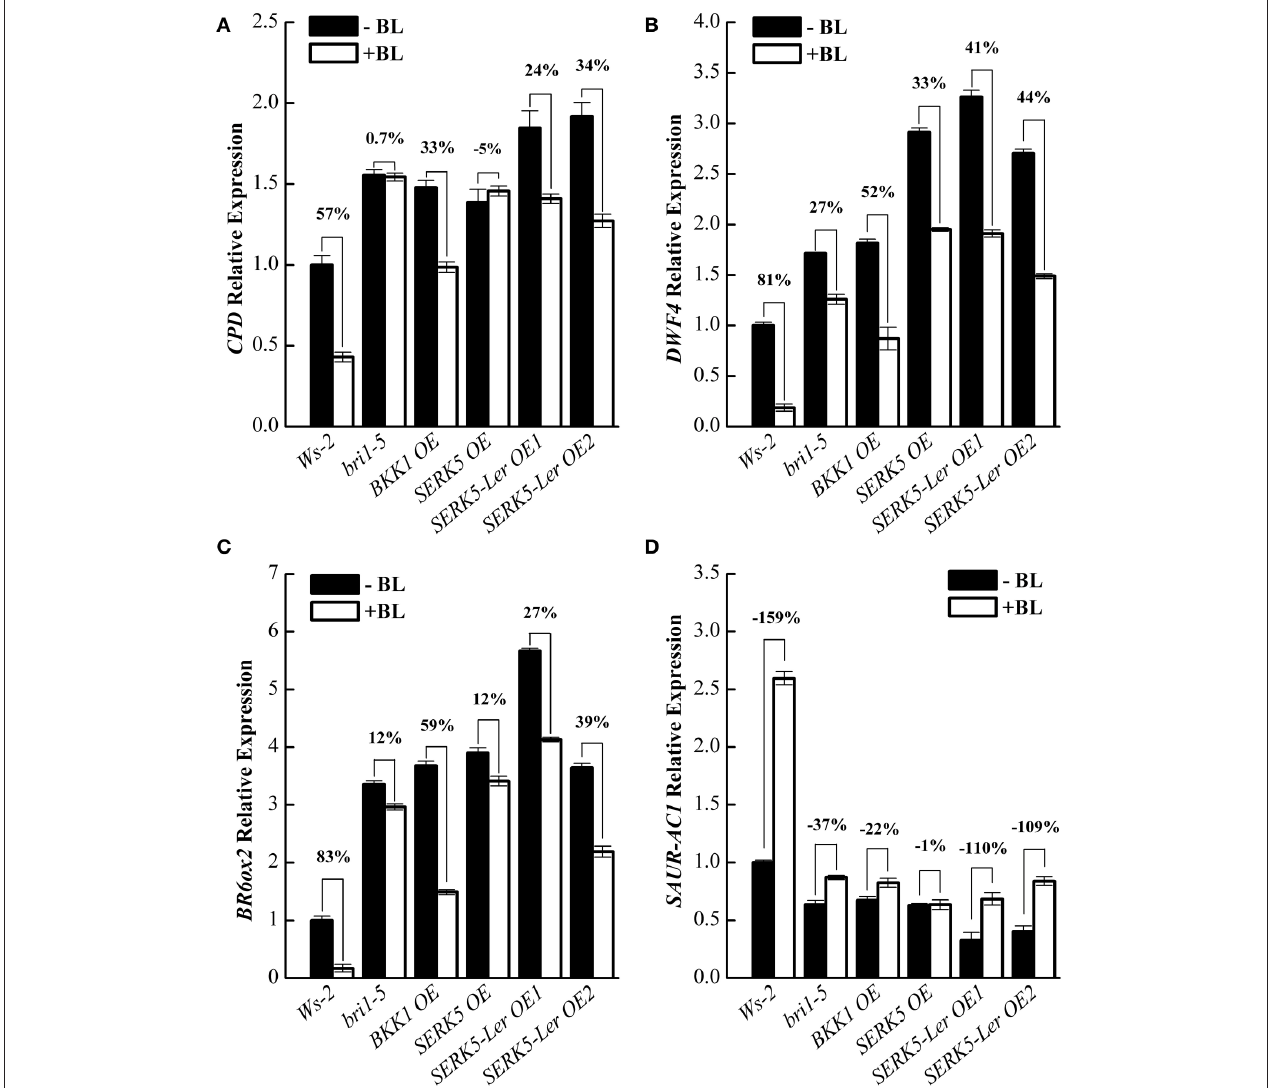
FIGURE 4 | Overexpression of SERK5 -L er partially restores BR signaling in bri1-5 . (A–D) 10-day-old seedlings grown on 1/2 MS medium were treated with or without 1 µ M 24-epiBL for 3h. Relative expression levels of CPD , DWF4 , BR6ox2, and SAUR-AC1 was examined by qRT-PCR. Overexpression of SERK5 -L er partially recovers the sensitivity of BR-responsive genes in bri1-5 upon BL treatment. ACTIN2 was used as the reference gene. Values are means ± SE ( n = 3 ). Experiments were repeated three times with similar results.